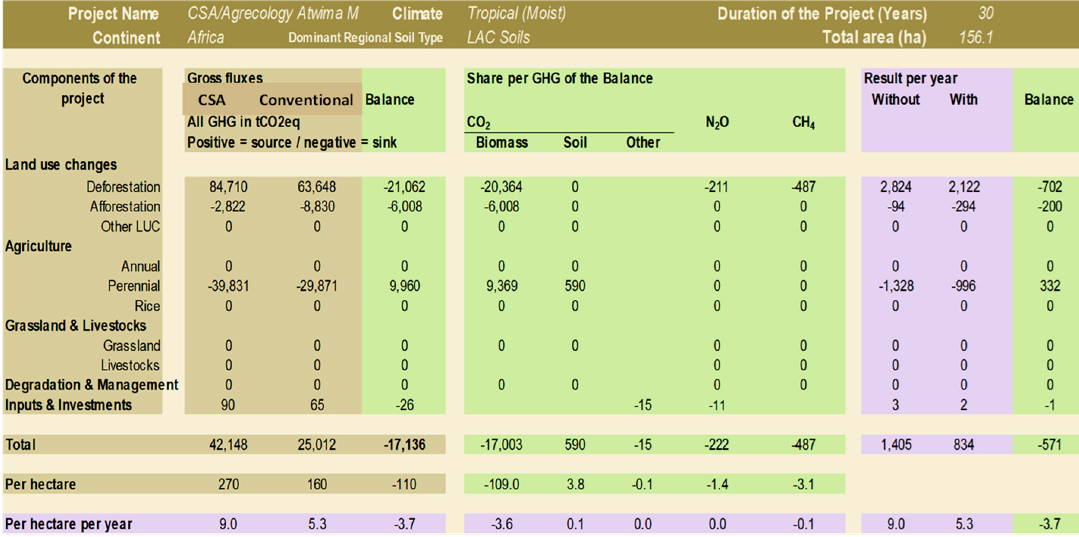
Figure 3. EX-ACT results showing fluxes per relevant component in cocoa farm projects in Atwima Mponua. Source: Field Data (2015).